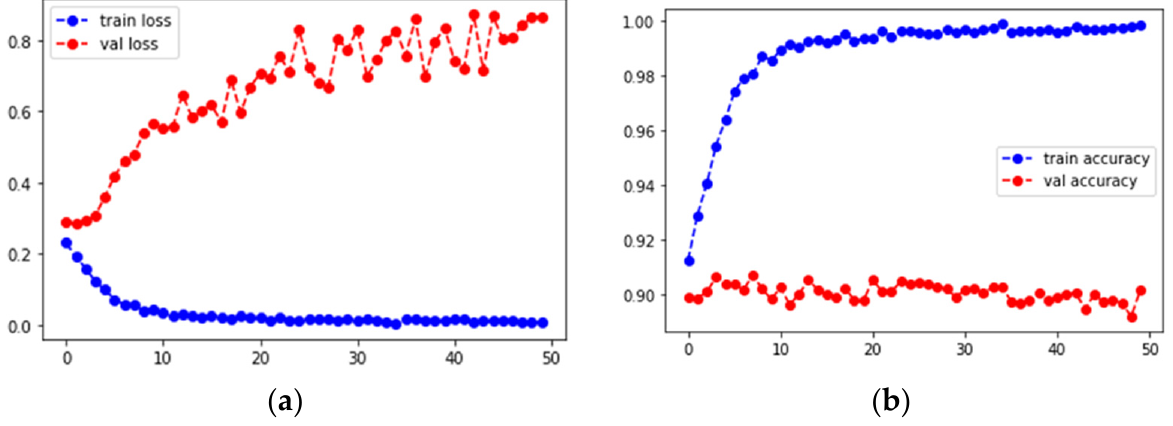
Figure 12. Training and testing of VGG16 + HPO model: ( a ) training and validation accuracy, ( b ) training and validation loss. Table 7. Summary of VGG16 transfer learning results. Transfer Learning Model